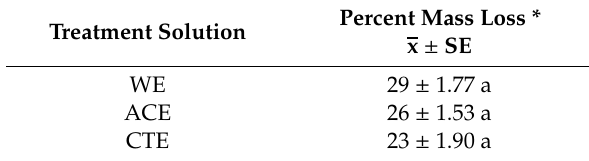
Table 1. E ff ect of treatment on wood mass loss after 18 days of exposure to Reticulitermes virginicus .